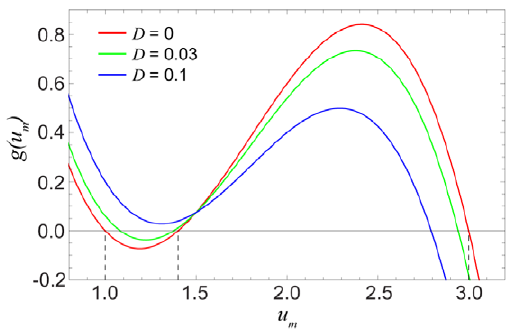
Figure 5. Functions g ( u m ) for three different values of D . The other parameters are r 1 ~ 1 , r 2 ~ 1 : 4, r 3 ~ 3 and k ~ 4 .